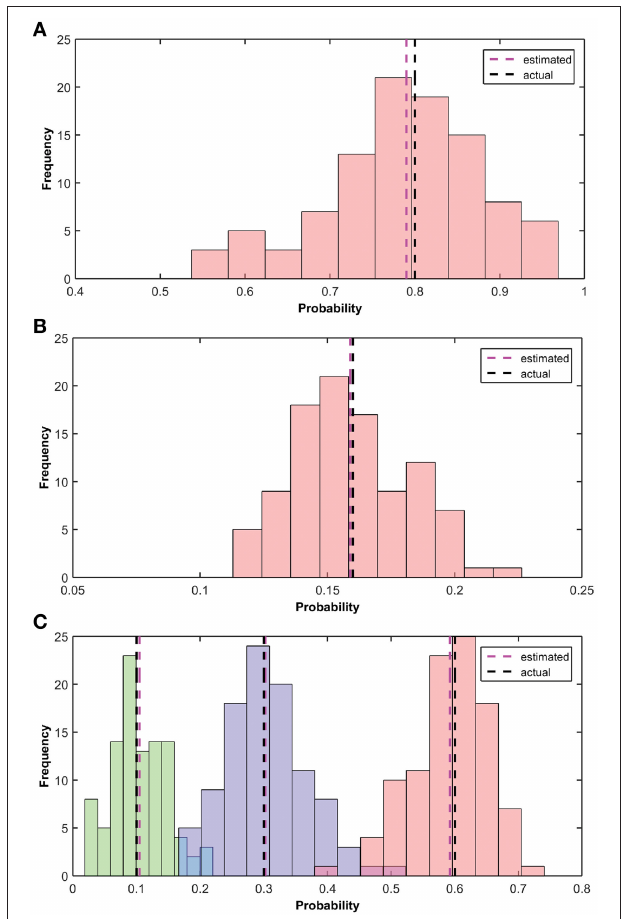
FIGURE 10 | Estimation of α , β and the transitional probability. (A) Histogram of the estimated observation probability ( α ) is shown using pink bars. True (0.8) and average estimated (0.79) observation probabilities are shown using black and pink dotted lines, respectively. (B) Histogram of the estimated parameter αβ is shown using pink bars. True (0.16) and estimated (mean) parameter αβ (0.159) are shown using black and pink dotted lines, respectively. (C) Histogram of the estimated transition probabilities [Left, Stay, Right] of 100 different simulations are shown in [Green, Blue, Pink], respectively. True transition probability [0.1, 0.3, 0.6] and estimated (mean) transition probability [0.105, 0.302, 0.59] are shown using black and pink dotted lines, respectively.